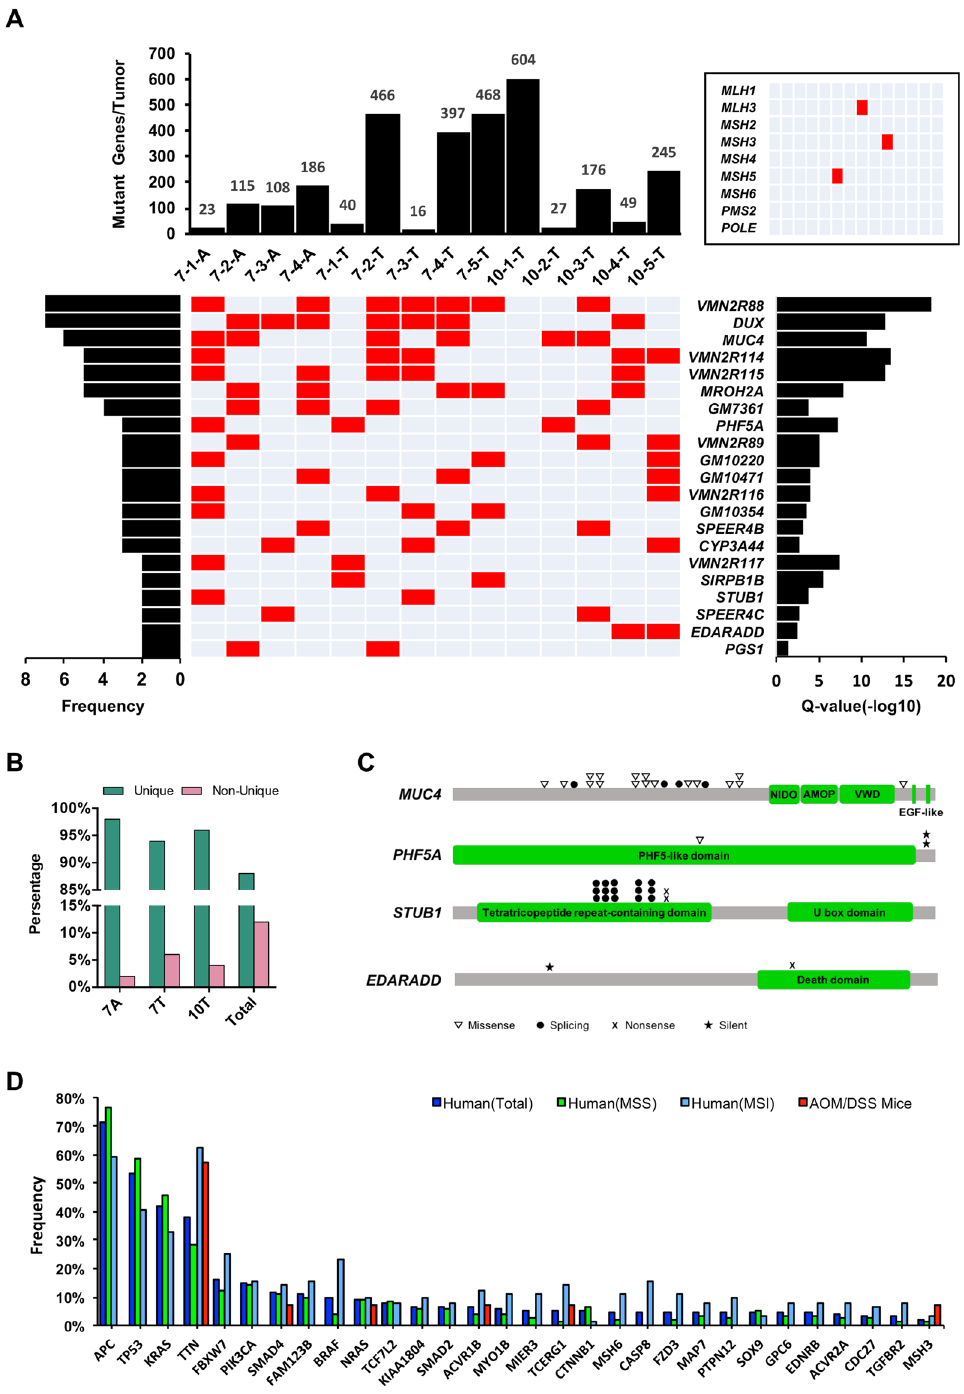
Figure 4. Landscape of somatic mutant genes in AOM/DSS mouse model and its comparisons with Human CRC. ( A ) Number of somatic mutant genes in each of 14 neoplastic samples are indicated with bar plot. The recurrent SMGs (P-value < 0.01 and Q-value < 0.1) identified in AOM/DSS mouse model are listed vertically by frequent and Q-value. A heat map, in which a red square indicated mutation of specific SMG in corresponding sample, show the distribution of such SMGs in 14 neoplastic samples. By the left, the frequent of individuals with mutations of each gene is shown with bar plot, while by the right is the Q-value of each SMG. Another heat map in the upper right corner shows the mutational profiling of nine MMR genes in AOM/DSS mouse model. ( B ) Percentage values of sample-unique somatic mutant genes and non-sample-unique somatic mutant genes in group 7A, 7T, 10T and total of 14 neoplastic samples. ( C ) Mapping of somatic mutations in four cancer-related SMGs, MUC4, PHF5A, STUB1 and EDARADD. ( D ) Frequencies of the 30 SMGs of human CRC reported by TCGA in three groups of human CRC and AOM/DSS mice. Three groups of human CRC, Total, MSS and MSI, are indicated with blue, green and sky blue, respectively, while the group of AOM/DSS mice is indicated with